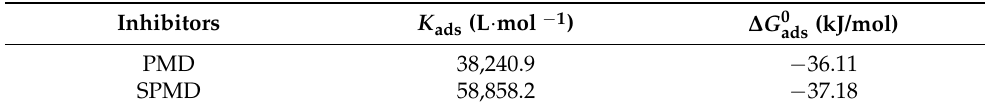
Table 3. Thermodynamic and equilibrium adsorption parameters for inhibitor adsorption behavior on iron in SCP solution.